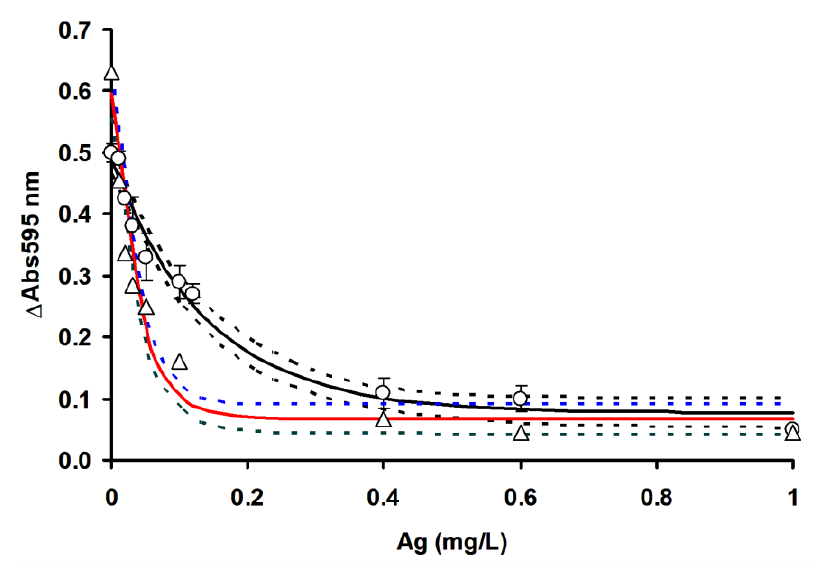
Figure 10. Ficin dye-binding assay of silver using RSM ( ) and OFAT ( (cid:52) ). Dashed lines represent the 95% confidence band. Error bars represent mean ± standard deviation ( n = 3).